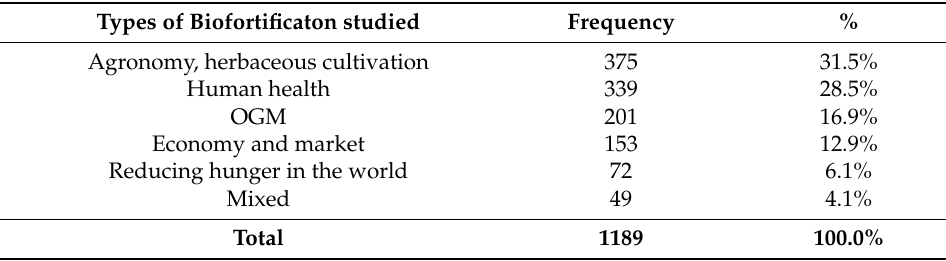
Table 4. Types of definitions studied in the